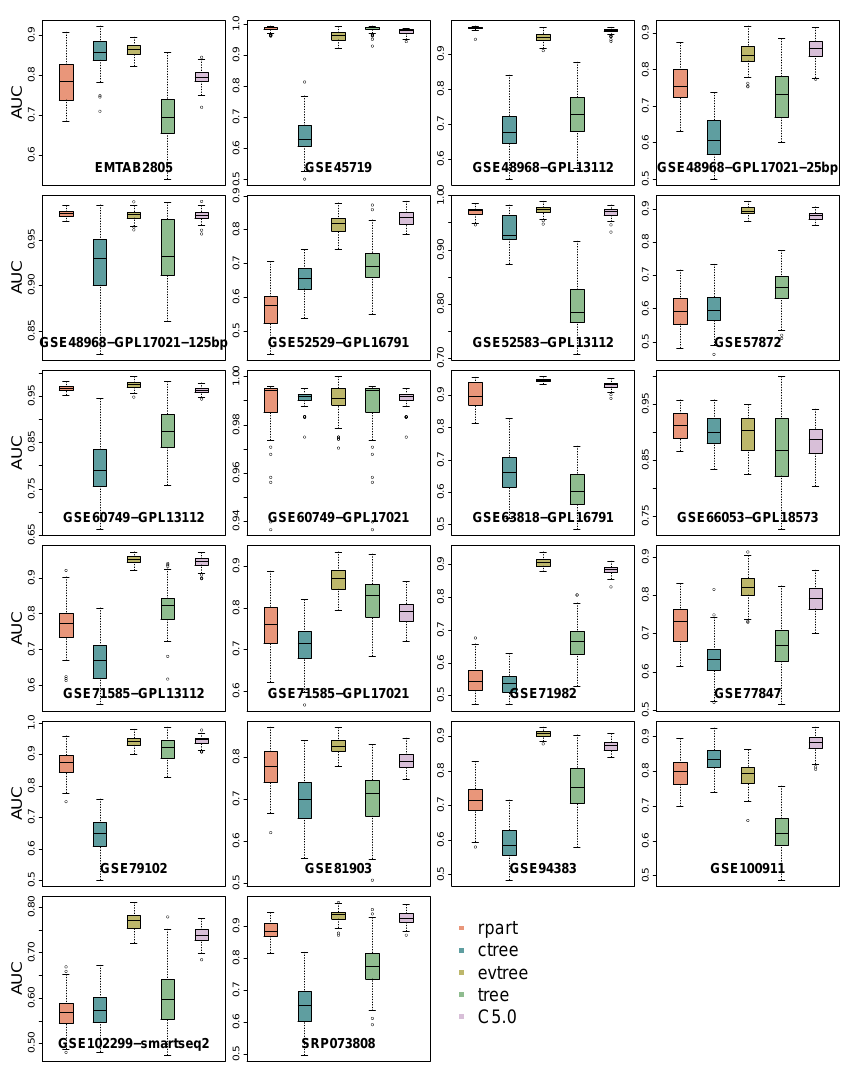
Figure 5. Methods’ AUC scores on all data